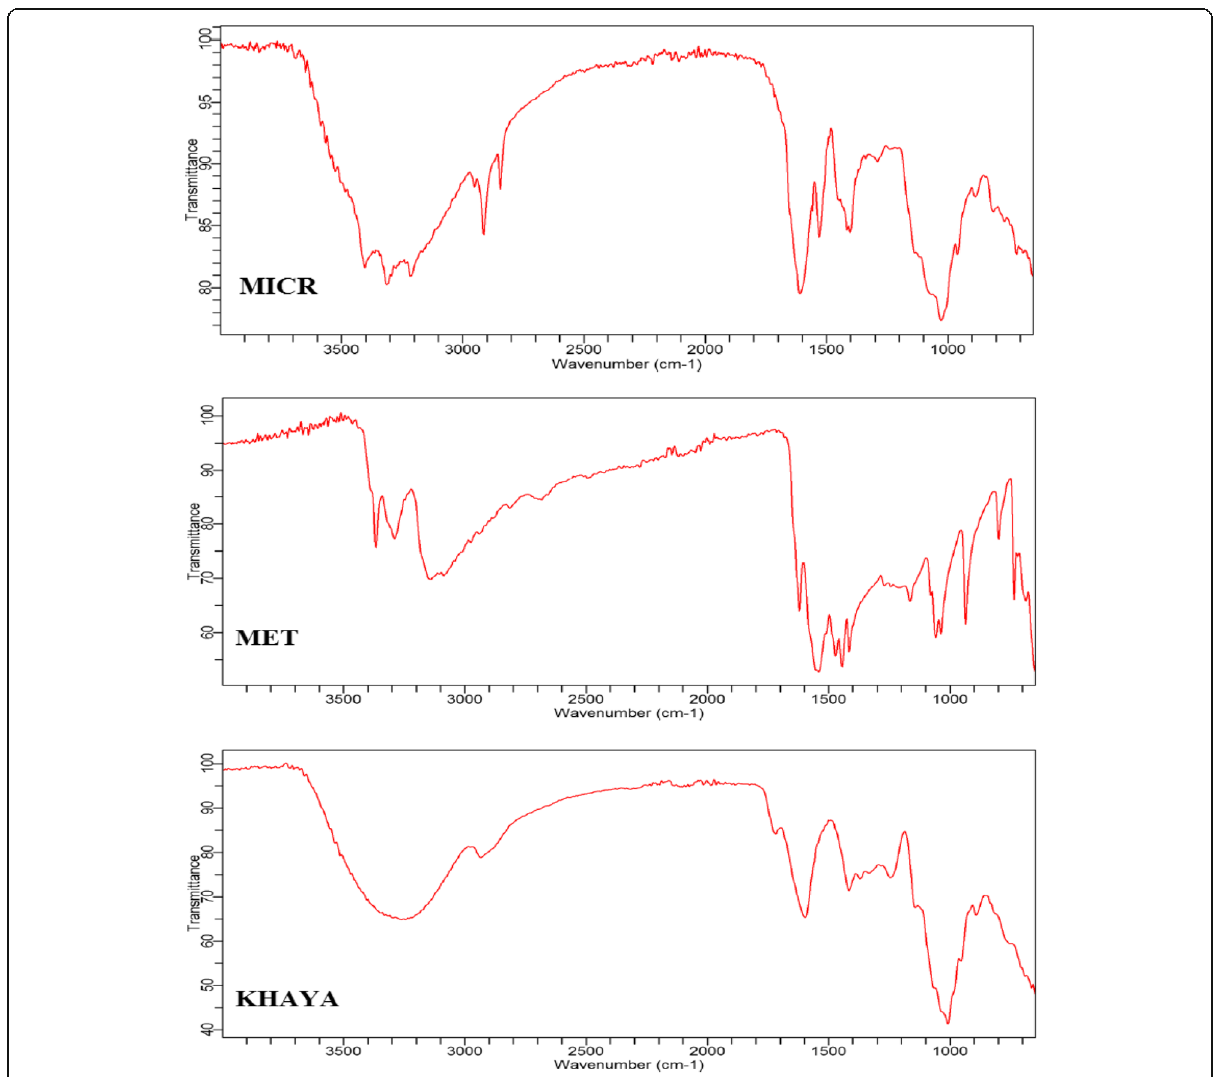
Fig. 4 Stacked FTIR spectra of Khaya senegalensis gum (KHAYA), pure metformin powder (MET), and microsphere (MICR)